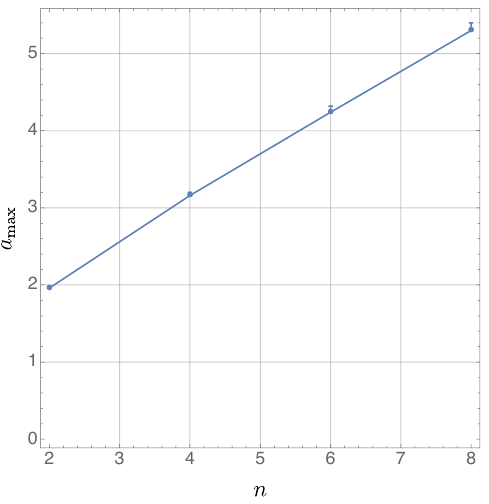
Figure 14 . a max as a function of n , computed for T = 3 = 4 (cid:25) .